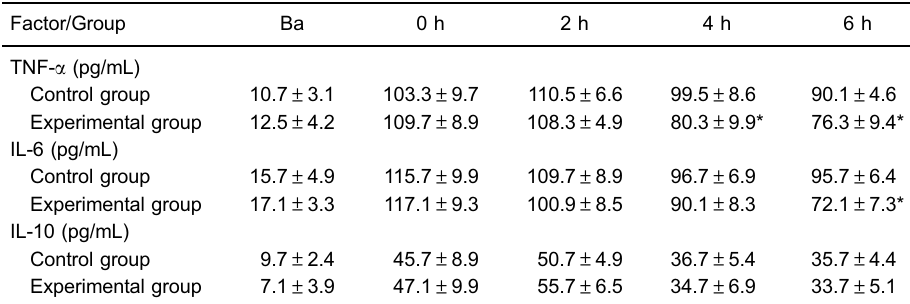
Table 4. In fl ammatory factor levels in bronchoalveolar lavage fl uid of male pigs induced with acute respiratory distress syndrome that received continuous veno-venous hemo fi ltration therapy (experi- mental) or conventional supportive therapy